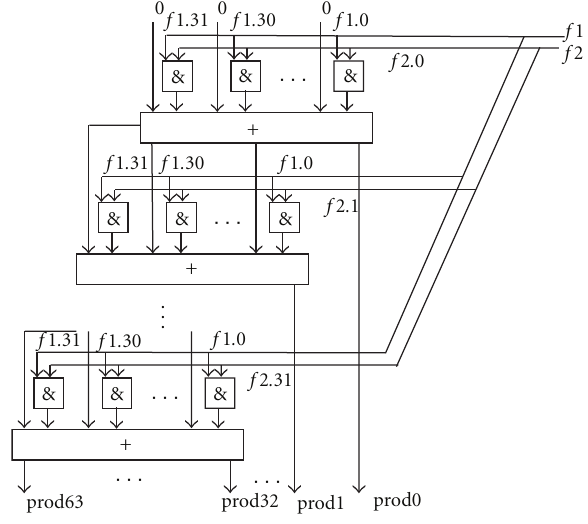
Figure 2: Structure of a field multiplier.